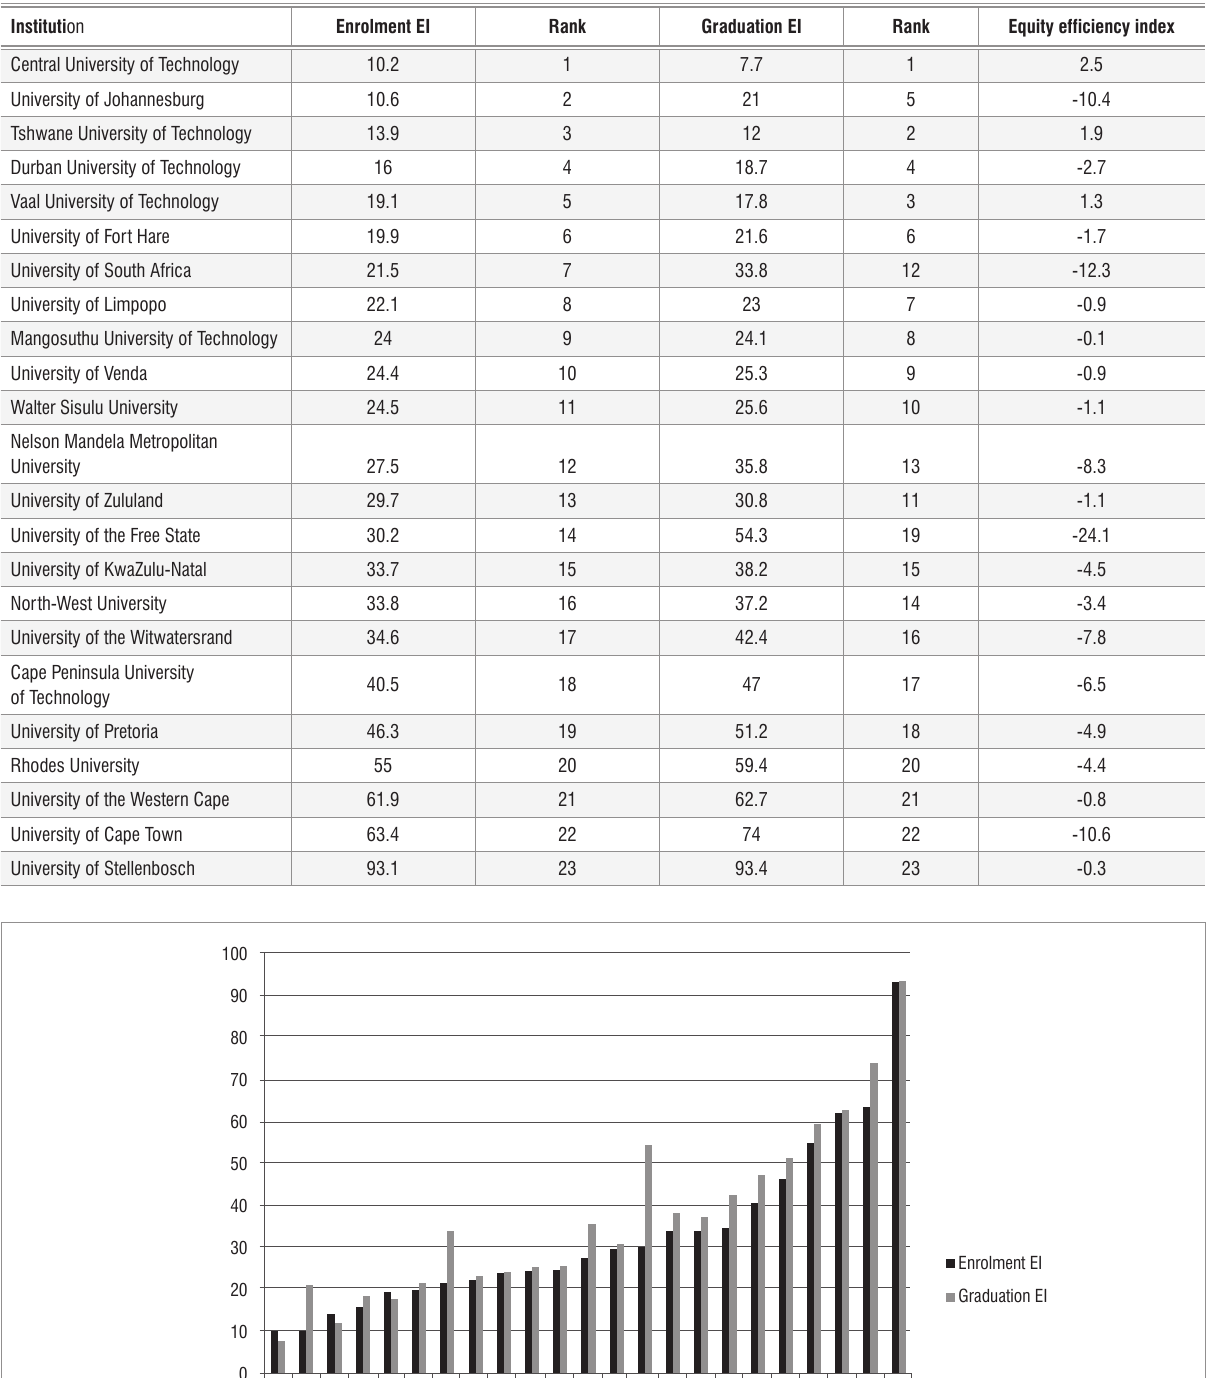
Table 3: Equity Indices (EIs) for South African student enrolment and graduation at South African universities Instituti on Enrolment EI Rank